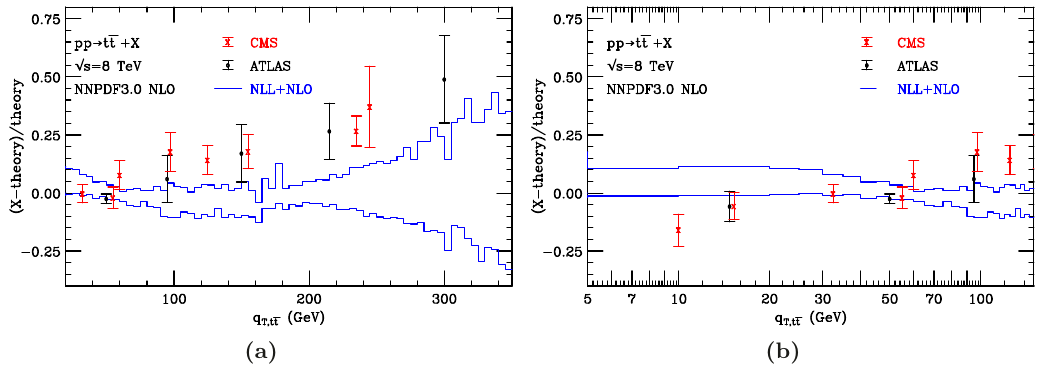
Figure 7. Fractional difference of scale dependent NLL+NLO prediction and LHC data [17, 18] with respect to the NLL+NLO result at µ F = µ R = Q = m t . The results refer to the normalized q T distribution 1 /σ ( dσ/dq T ) of t ¯ t pairs at √ s = 8 TeV. The two panels highlight (a) the intermediate and large q T region and (b) the small- q T